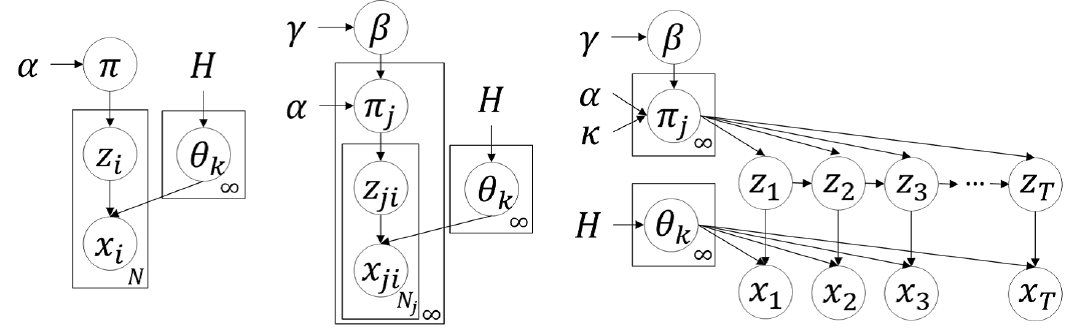
Figure 3: Dirichlet process mixture model(a), Hierarchical Dirichlet Process(b) and sticky HDP-HMM(c) markov model is called hierarchical dirichlet process -